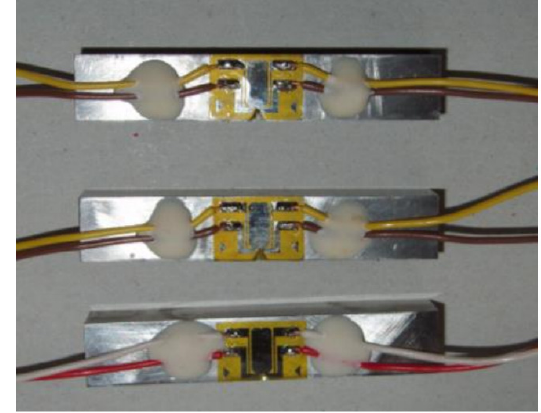
Figure 4. Strain gauge RUMUL RMF A-5 located on the specimen face surface Strain gauges RUMUL RMF A-5 of 5 mm length are cemented on machined specimens, allowing crack growth monitoring by FRACTOMAT device, based on the electrical potential of gauge and connected with instrumentation, Figure 5. The measuring gauge, a thin resistant measuring foil, is cemented on the specimens in the same way as classical strain gauges. As the crack grows under the measuring foil causing it to rip, it traces the fatigue crack tip, changing foil electrical resistance linearly with the crack length [1,10].